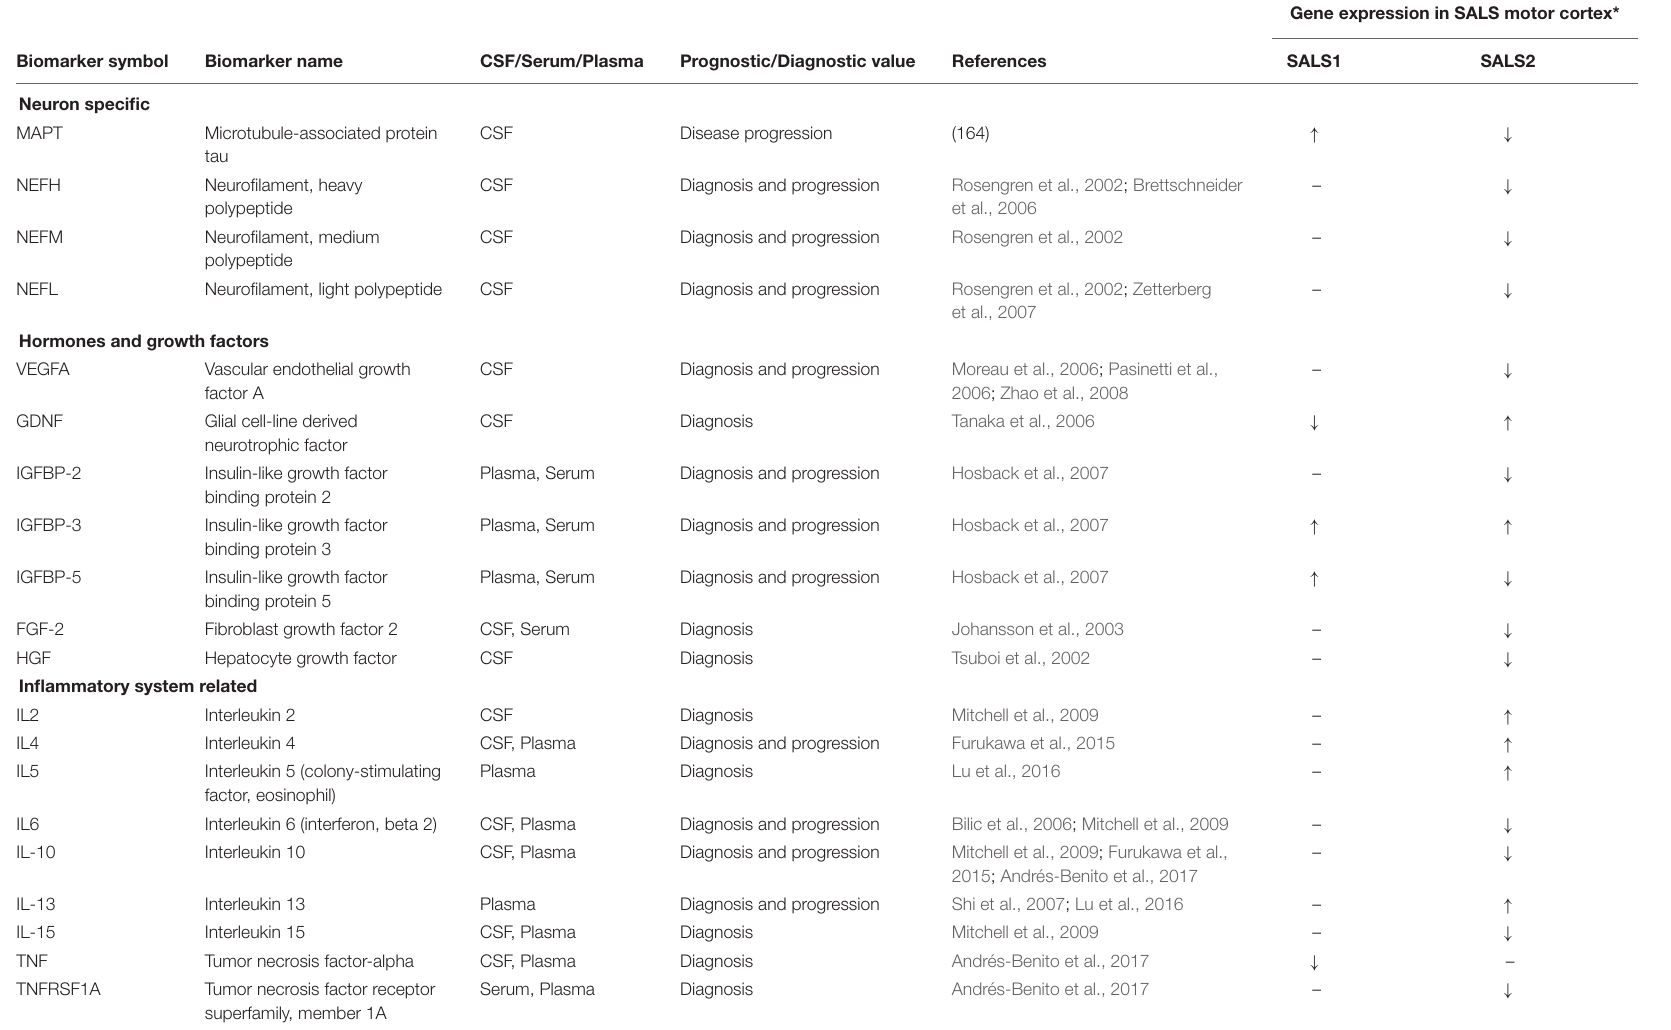
TABLE 2 | Putative protein biomarkers and their differential expression in distinct SALS patient